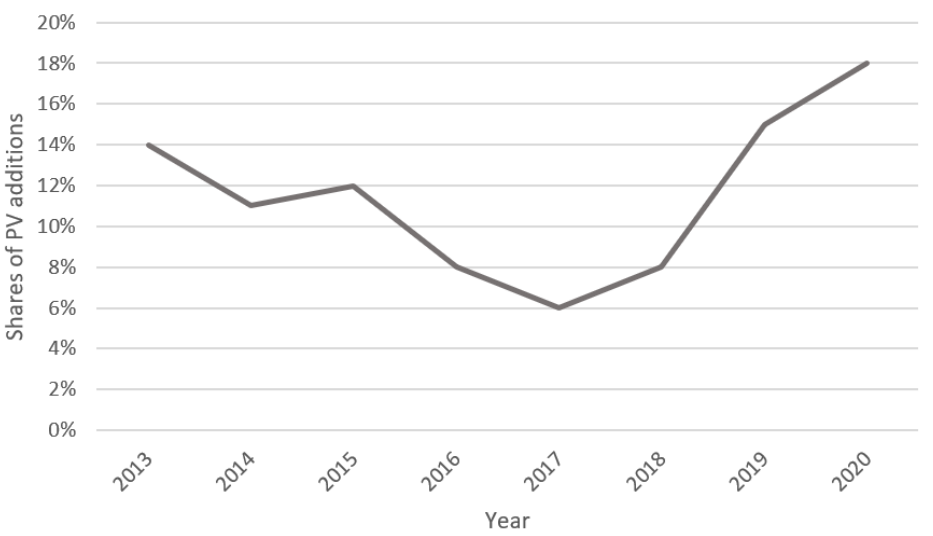
Figure 6. World shares of residential PV net capacity addition per year. (Data collected from [69] on 26 May 2021).